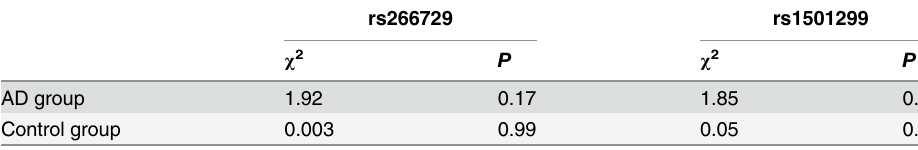
Table 3. Hardy-Weinberg analysis of rs266729 and rs1501299.